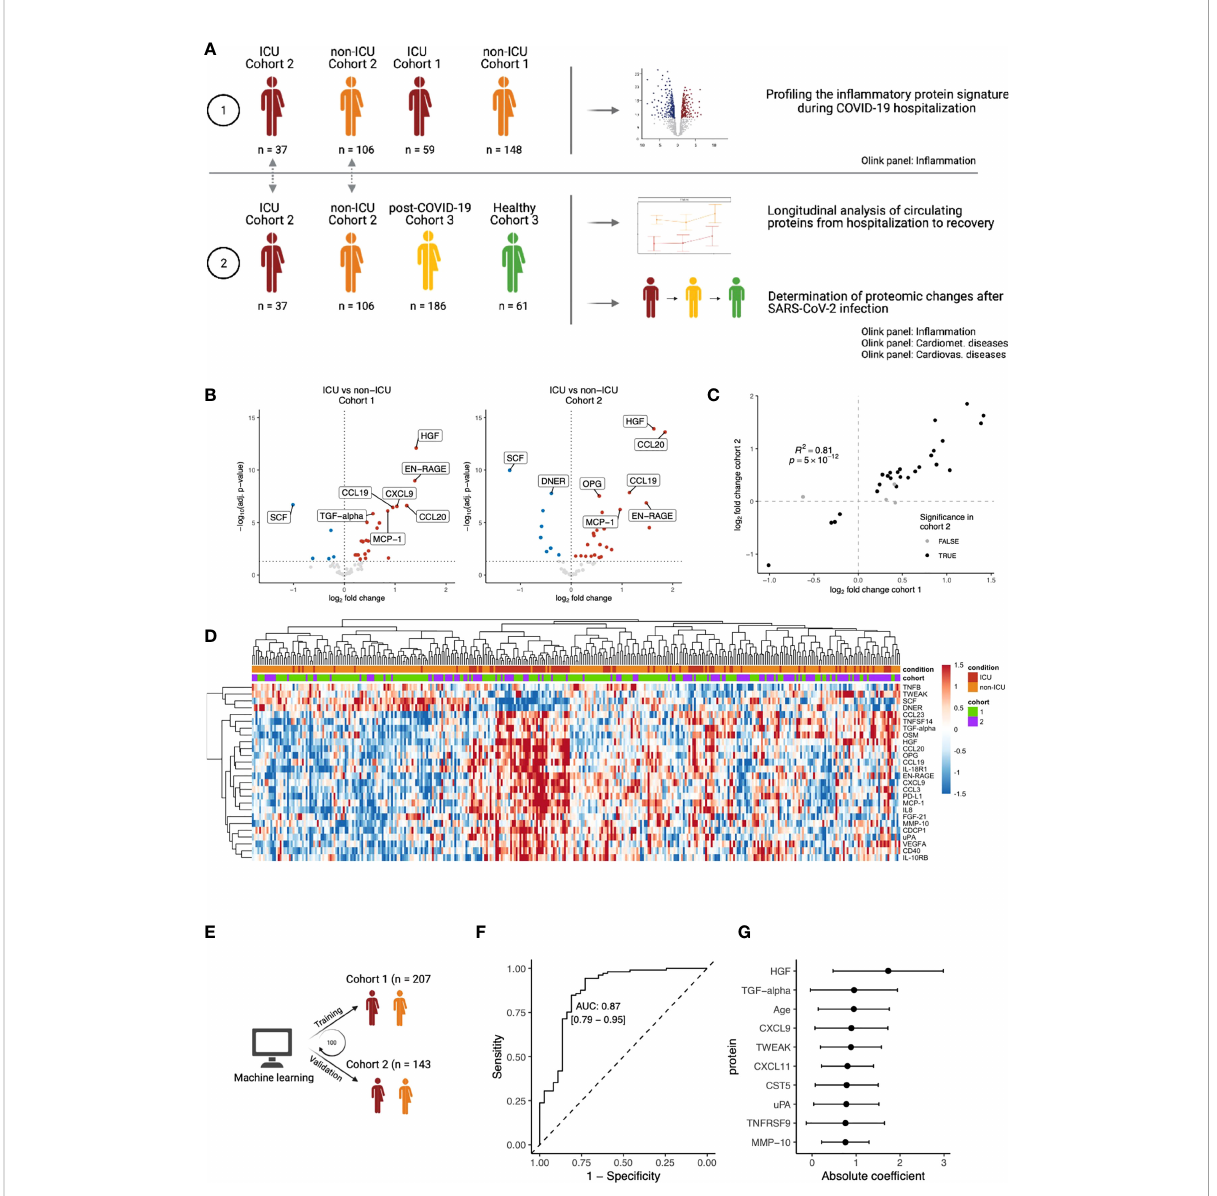
FIGURE 1 In fl ammatory proteomic pro fi le of hospitalized COVID-19 patients. (A) Schematic overview of the study design. (B) Differential abundance analysis on in fl ammation-related of ICU vs. non-ICU patients in cohorts 1 and 2, separately. Upregulation (red) indicates higher protein concentrations in ICU patients, whereas downregulation (blue) indicates downregulation in ICU patients. Proteins that are not signi fi cantly different are shown in grey. The vertical dotted line indicates log-fold change 0. The horizontal dotted line indicates signi fi cance at the adjusted p -value level. For both cohorts, only the fi rst time-point per patient was considered. Since we focus on the in fl ammation-related proteins in this analysis, only proteins belonging to the Olink In fl ammation panel are depicted. The complete differential abundance results are included in Table S2. (C) Replication of the signi fi cantly regulated proteins from cohort 1 in cohort 2. The log-fold changes per protein are strongly correlated (Pearson ’ s r 2 : 0.81). Overall, 62 proteins overlapped between the cohorts. 30 proteins were signi fi cant in cohort 1, of which 26 were signi fi cantly replicated in cohort 2 (FDR<0.05 and the same direction of regulation, shown in black). (D) Heatmap of the 26 replicated proteins (FDR < 0.05 & same direction of regulation in cohorts 1 and 2). Each column represents a patient, whereas rows represent proteins. The column annotations indicate the condition of each patient and the cohort to which they belong. Samples were clustered based on correlation. (E) Schematic overview of the training process for an elastic net linear regression model to discriminate between COVID-19 disease severity. The larger cohort 1 was used as a training cohort, and the smaller cohort 2 for validation. 100 independent training iterations were performed and combined to avoid potential bias. (F) Receiver-operating characteristic curve produced by one random iteration of the classi fi cation model on the independent validation data from cohort 2. The AUC was 0.86 (sensitivity: 0.76, speci fi city: 0.86). (G) Mean coef fi cients per protein were calculated over 100 independent training runs for the model. The top ten proteins with the highest absolute mean coef fi cients are shown. Dots indicate the mean absolute mean coef fi cient per protein, and error bars indicate standard